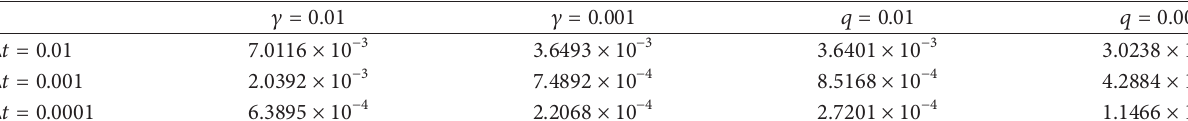
Table 4: The errors for different Δ𝑡 .